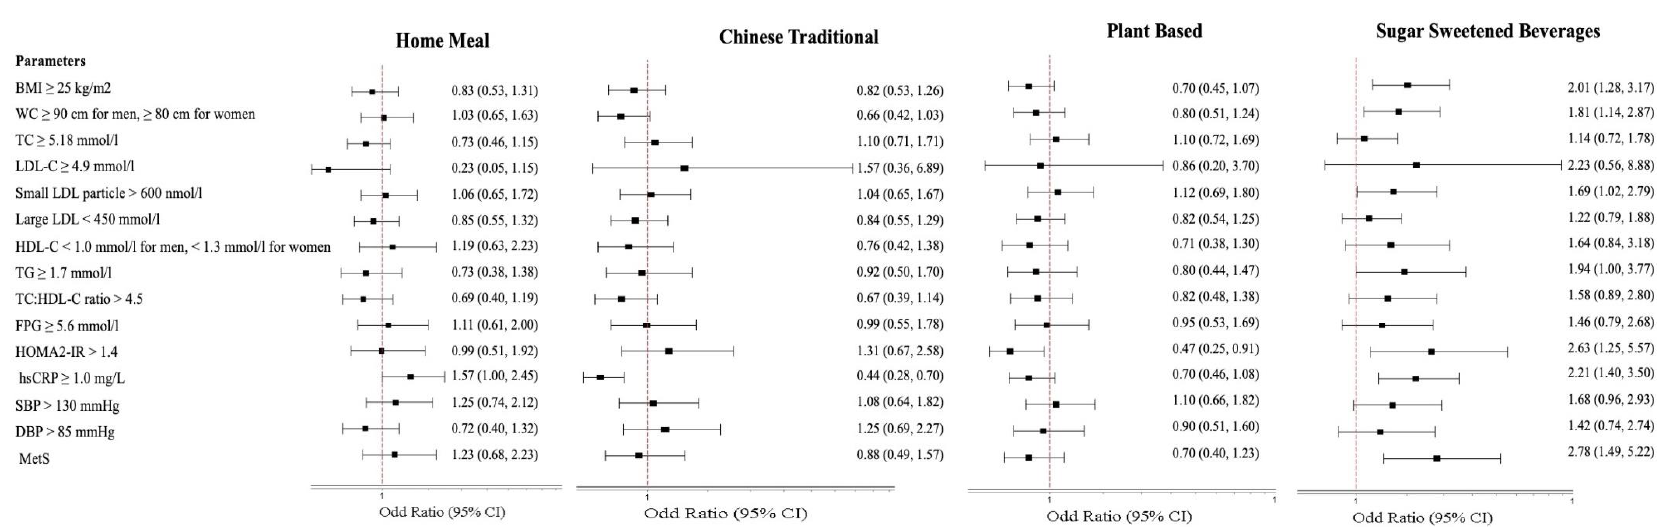
Figure 2. Associations between cardiometabolic markers and T3 vs. T1 of dietary patterns. Data are expressed as odds ratio (95% confidence interval) of T3 against odd ratio of T1 set as 1.0; † Multiple logistic regression test for comparison between tertiles (T3 vs. T1) adjusted for age and gender. Abbreviations: AOR = adjusted odds ratio; BMI, body mass index; CI, confidence interval; DBP, diastolic blood pressure; FPG, fasting plasma glucose; HDL, high density lipoprotein; HOMA2-IR, homeostatic model assessment of insulin resistance; hsCRP, high-sensitivity C-reactive protein; LDL-C, low density lipoprotein; MetS, Metabolic Syndrome; SBP, systolic blood pressure; TC, total cholesterol; TC:HDL-C, total cholesterol high density lipoprotein ratio; TG, triglyceride; WC, waist circumference.